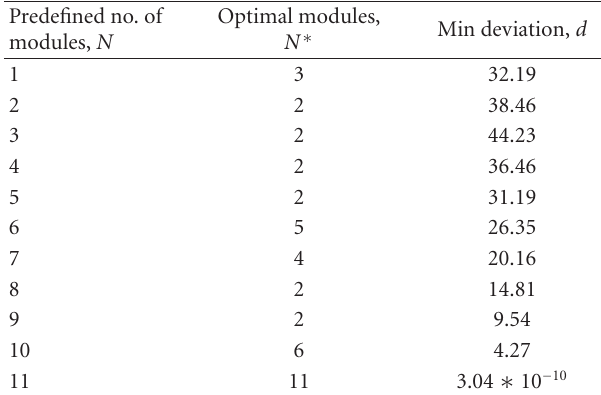
Table 4: E ff ect of N on optimal modules, N ∗ and min deviation, d —stakeholder 1 rating.